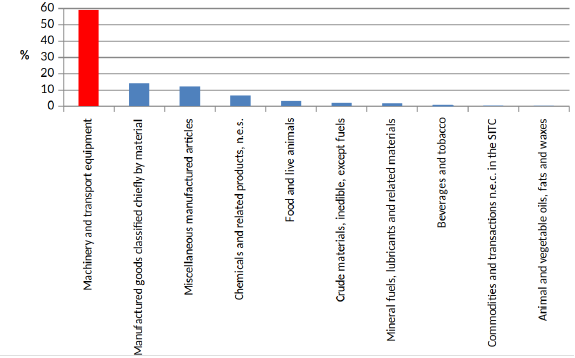
Figure 1. Cross-border movements of goods by com- modities, year 2019, source: CZSO